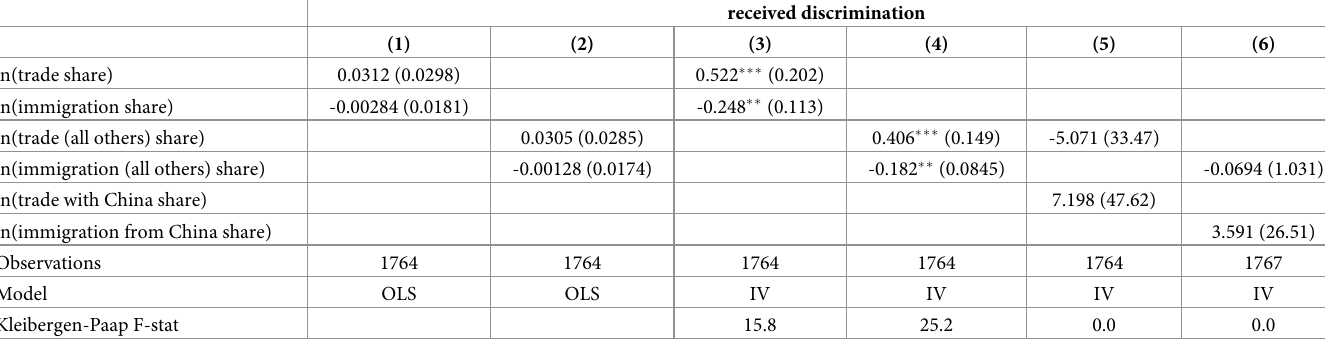
Table 10. Discrimination, openness to trade and immigration (alternative trade data from